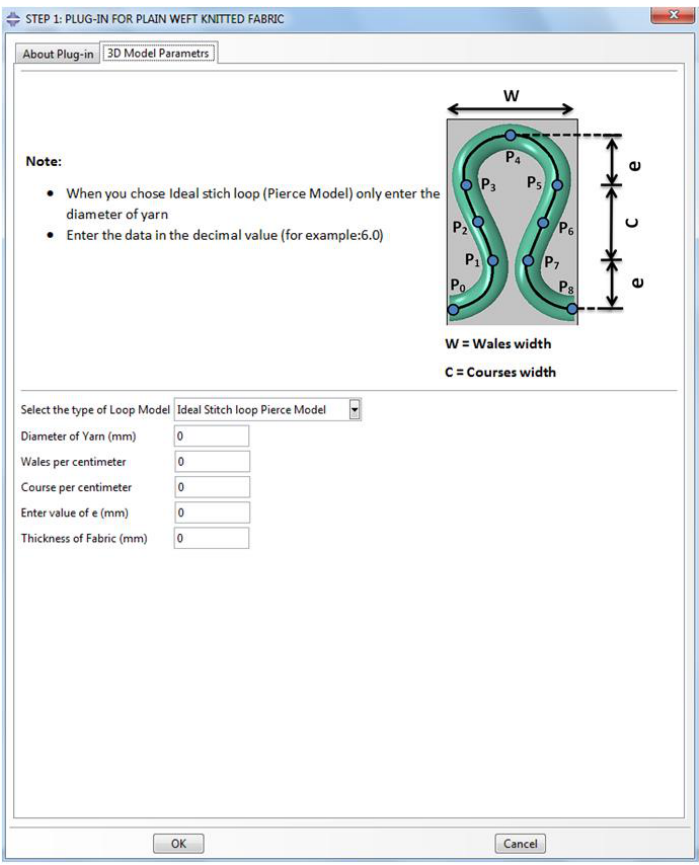
Figure 3. Plug-in user interface for generating solid plain weft knitted fabric